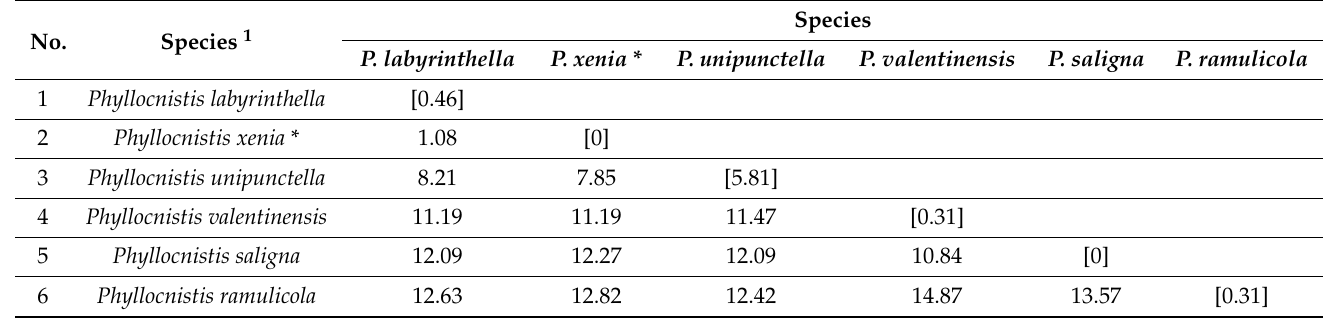
Table 1. Intra- and interspecific genetic divergences in DNA barcodes between Phyllocnistis species documented in the Volˇcji Potok Arboretum (Slovenia) assessed based on Kimura 2-parameter (K2P) distances (%). For each species pair, the minimum pairwise distance is provided; values in square brackets show maximum intraspecific